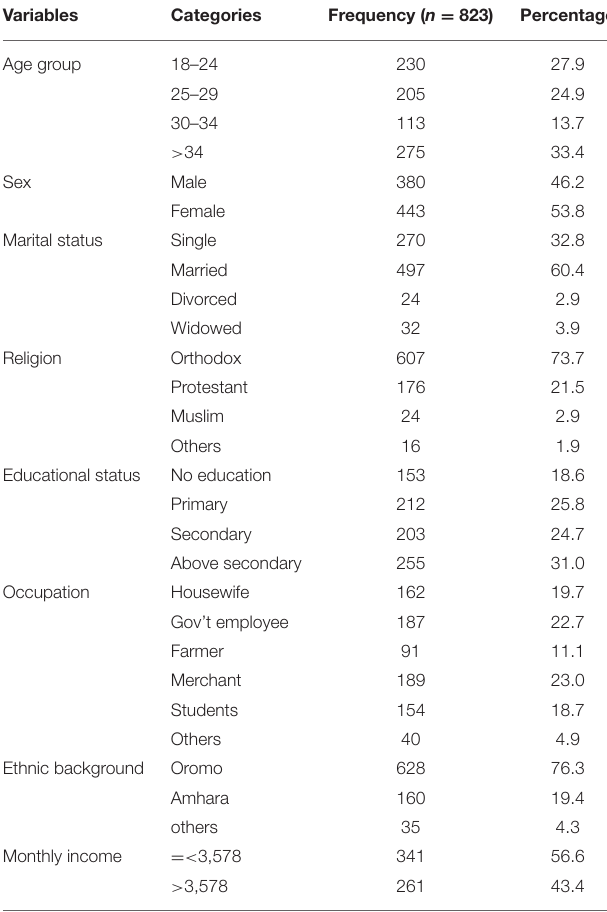
TABLE 1 | Socio-demographic characteristics of adult residents of selected towns in North Shewa zones, Oromia region, central Ethiopia, 2021.